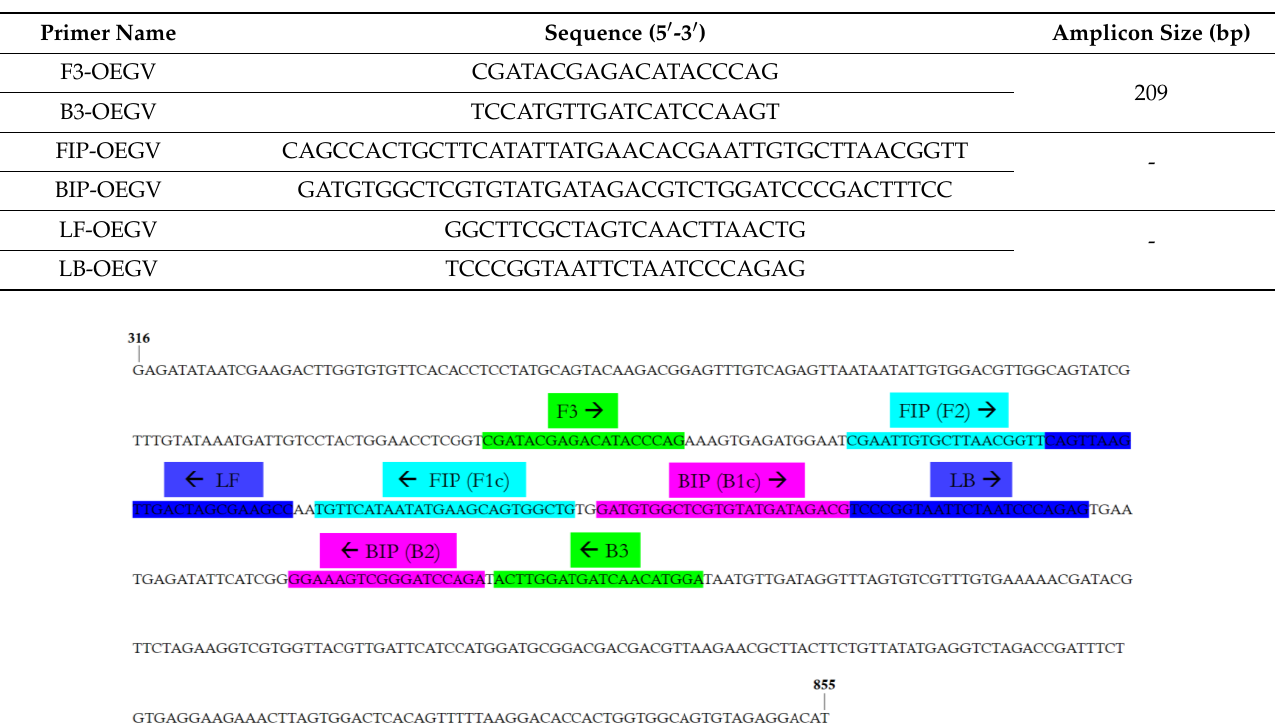
Figure 1. Location of loop-mediated isothermal amplification (LAMP) primer sets designed on the AV1 coding region of OEGV. F3 and B3 are shown in green, FIP (F1c-F2) in blue, BIP (B1c-B2) in pink, and the two loop primers LF and LB in brown. FIP is a hybrid primer consisting of the F1c and the F2 sequences, while BIP is a hybrid primer consisting of the B1c and B2 sequences. The arrows indicate the extension direction. The numbers at the beginning and end of the sequence represent the genomic position of the first and last nucleotide in the selected sequence (GenBank Acc. No. MW316657).